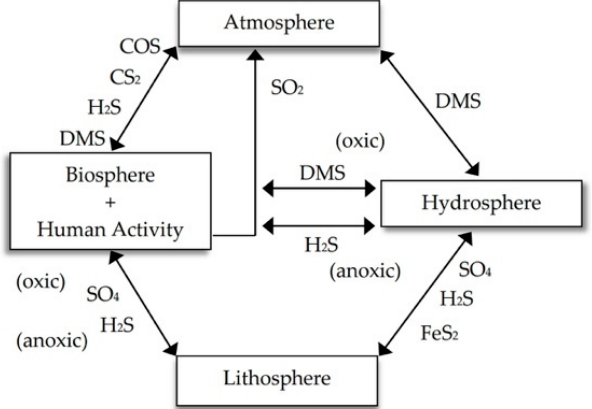
Figure 1. Simplified biogeochemical sulfur cycle. Human activities, fauna, vegetation, and soil microorganisms can be visualized as an interface (as source and sink) to accelerate the transfer of sulfur species between the lithosphere, atmosphere, and hydrosphere.